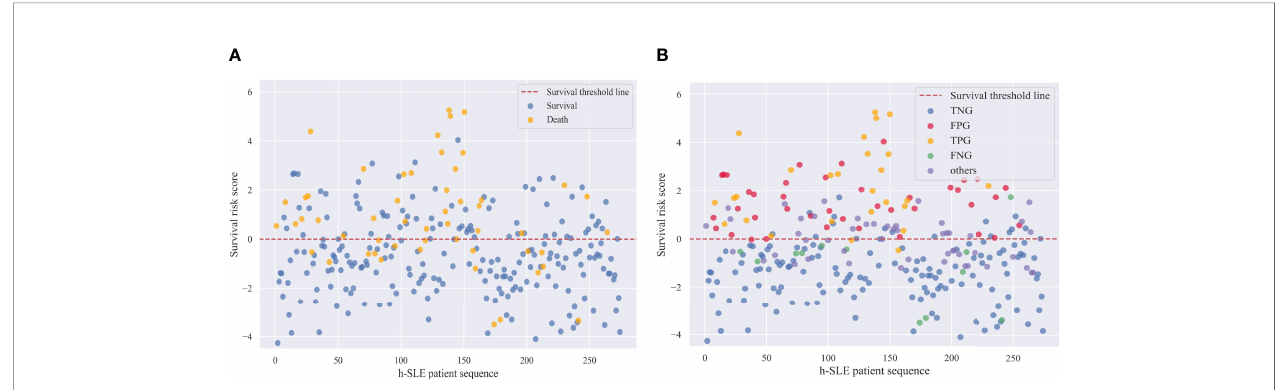
FIGURE 3 | Survival risk score of h-SLE patients in Train